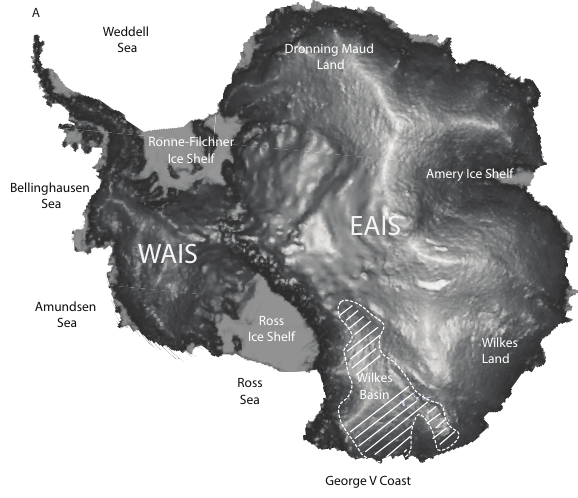
Figure 1. Map of the Antarctic Ice Sheet, highlighting the location of the Wilkes